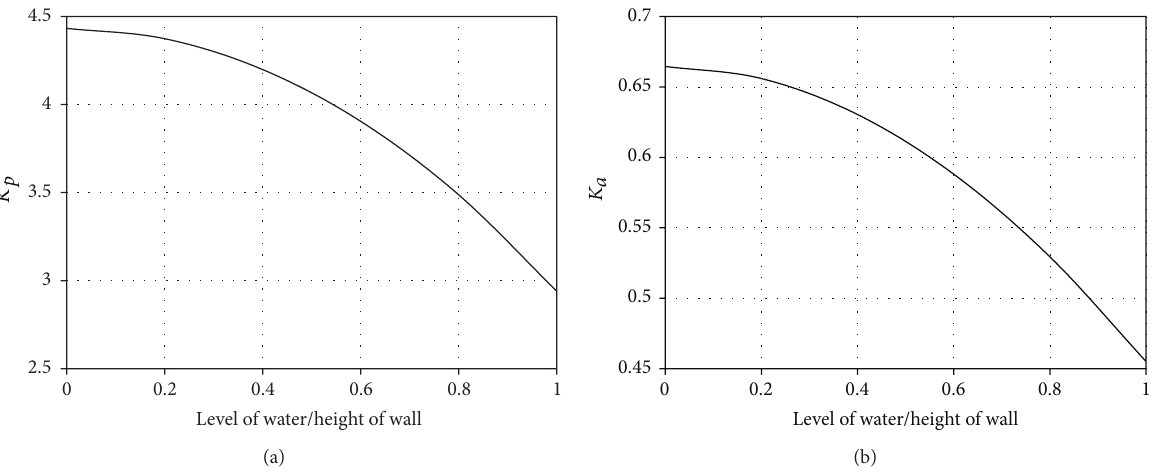
Figure 10: Effects of water table on lateral earth pressure coefficients.